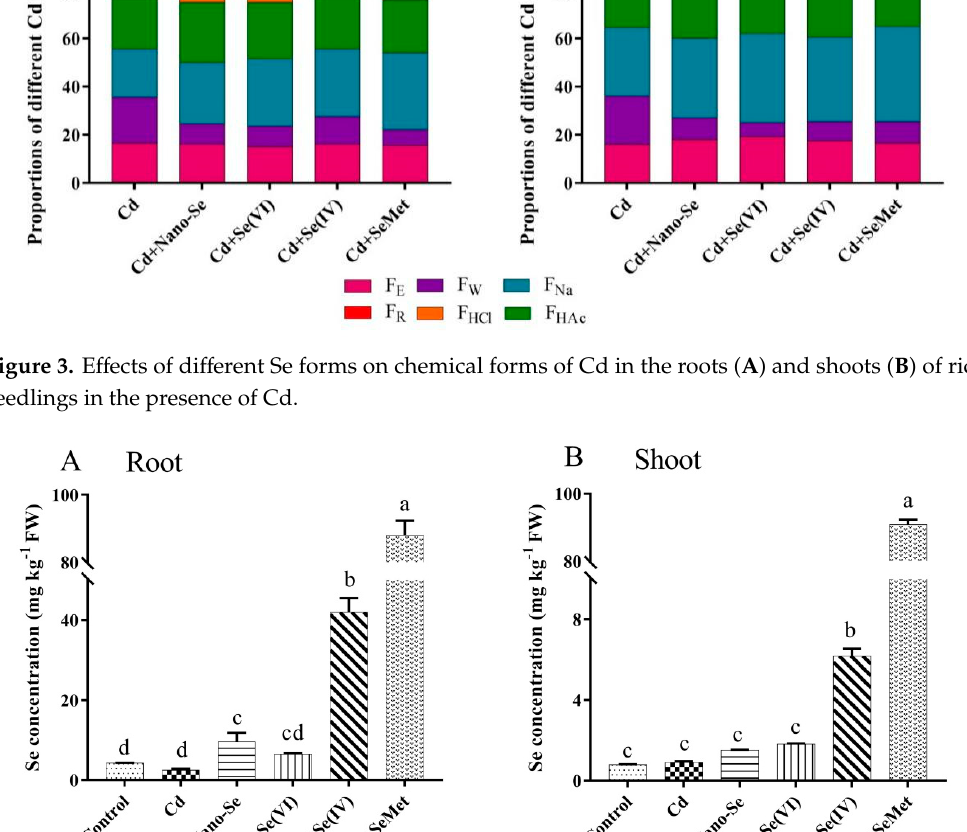
Figure 3. Effects of different Se forms on chemical forms of Cd in the roots ( A ) and shoots ( B ) of rice seedlings in the presence of Cd.